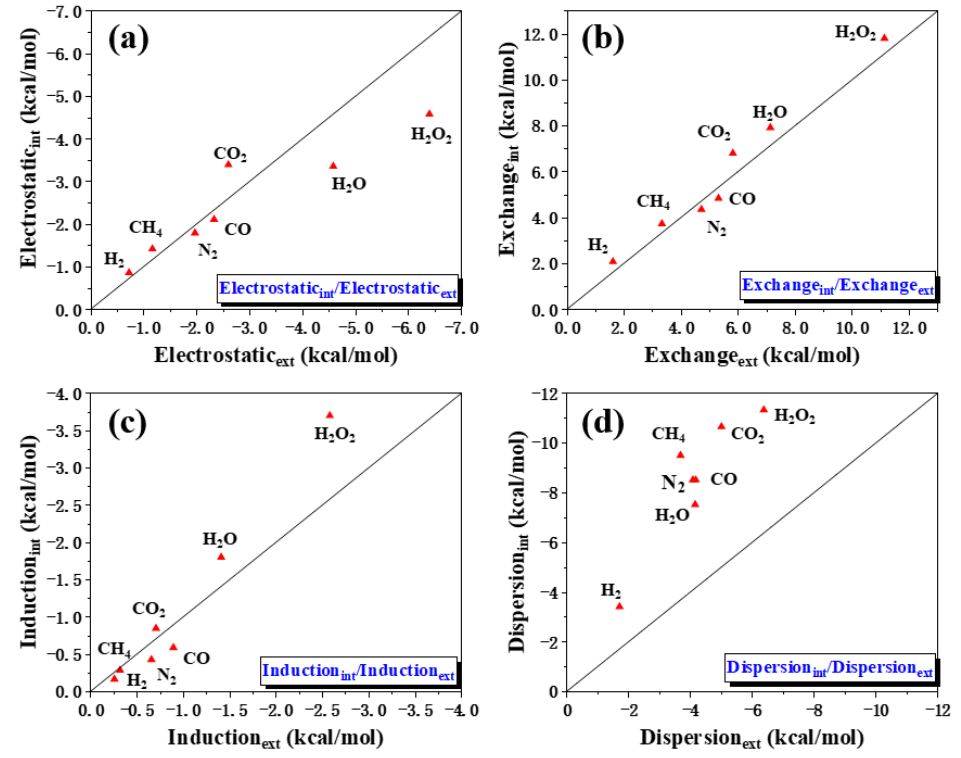
Figure 7. The ratio of different physical components of small molecules adsorbed on the inner and outer regions of [6, 6]CNB. Electrostatic ( a ), exchange ( b ), induction ( c ) and dispersion ( d ).